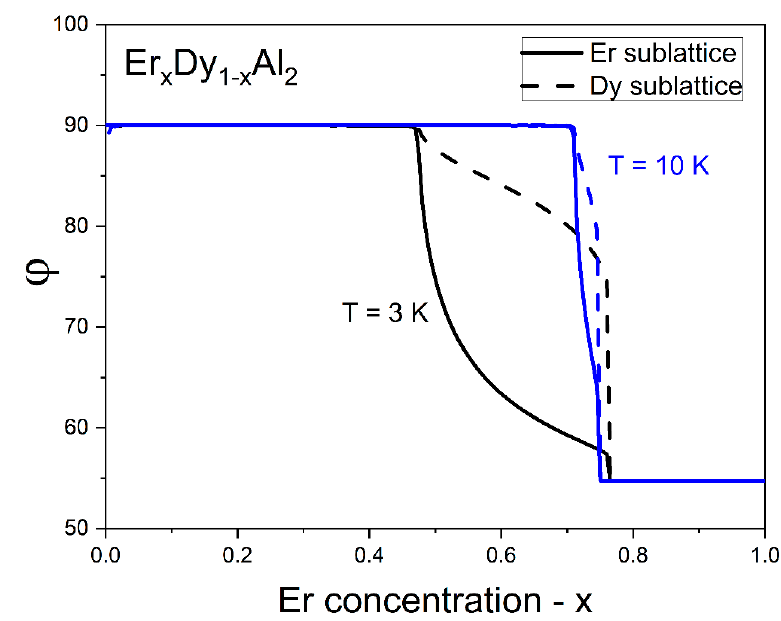
Figure 8. Er (cid:3051) Dy (cid:2869)(cid:2879)(cid:3051) Al (cid:2870) polar angle ( φ ) of each magnetic sublattice, Er (solid line) and Dy (dashed), as a function of Er concentration for T = 3 K and 10 K.